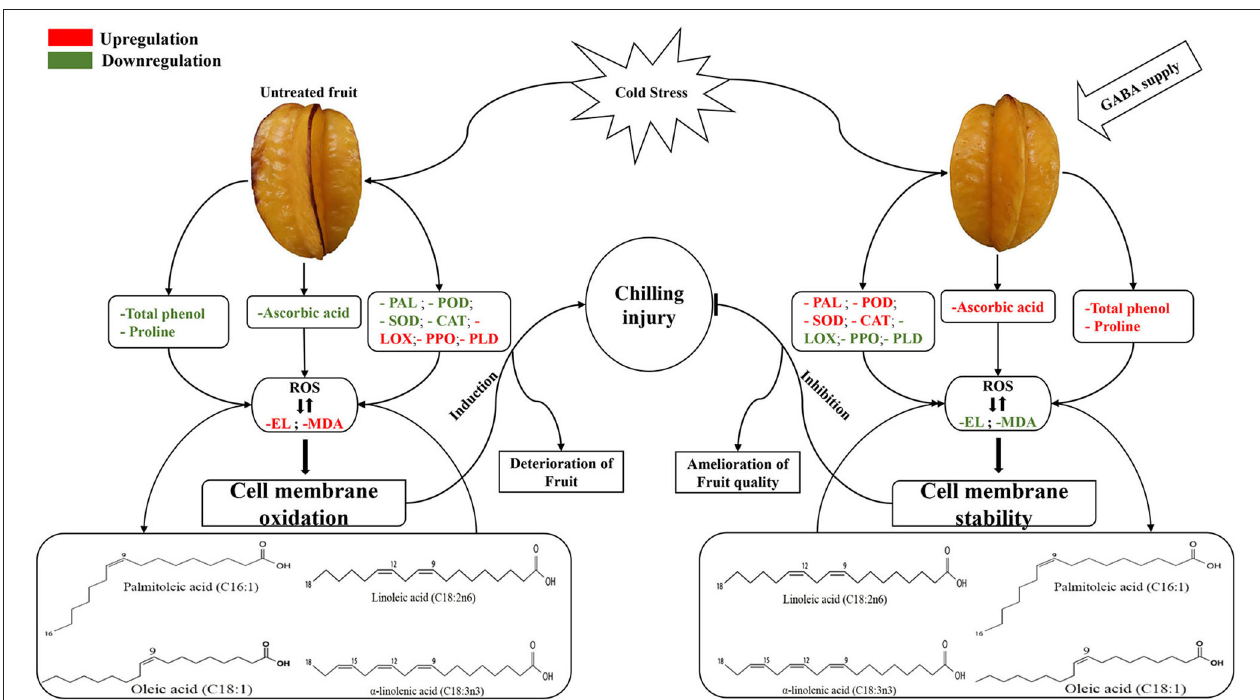
FIGURE 9 | A schematic diagram depicting the ability of GABA modulating enzyme activities and fatty acids composition, and promoting chilling tolerance in carambola